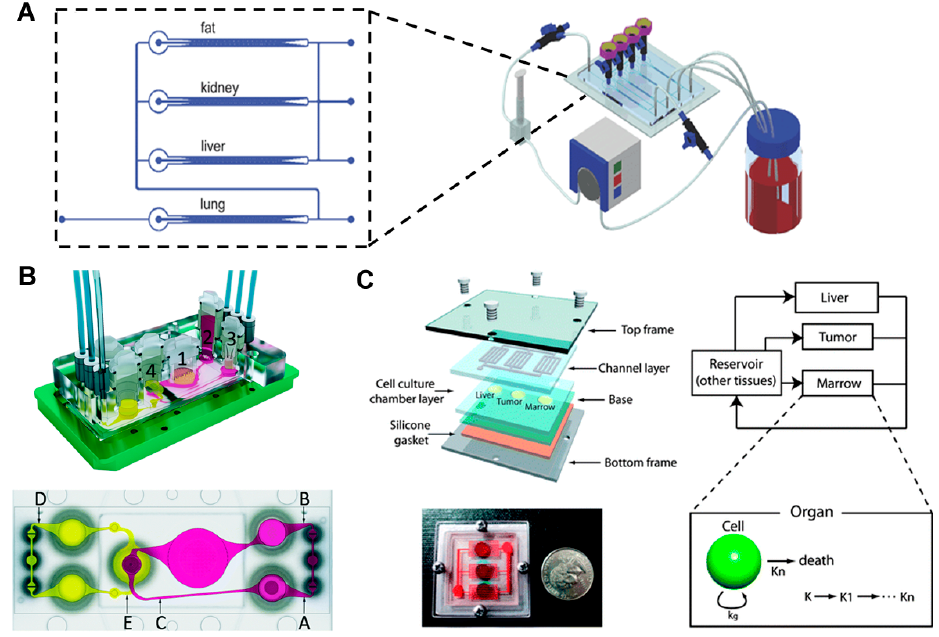
Figure 4. Multi-organ model ( A ) Multi-channel 3D microfluidic cell culture system for drug screening. Image reprinted from [44] with the permission of The Royal Society of Chemistry. ( B ) Microfluidic four-organ chip for mimicking the ADME processes. Image reprinted from [47] with the permission of The Royal Society of Chemistry. ( C ) Gravity-induced flow-based microscale cell culture analog ( µ CCA). A PK-PD model and a µ CCA were combined to study the mechanism of action of the drug. Image reprinted from [48] with permission of The Royal Society of Chemistry.